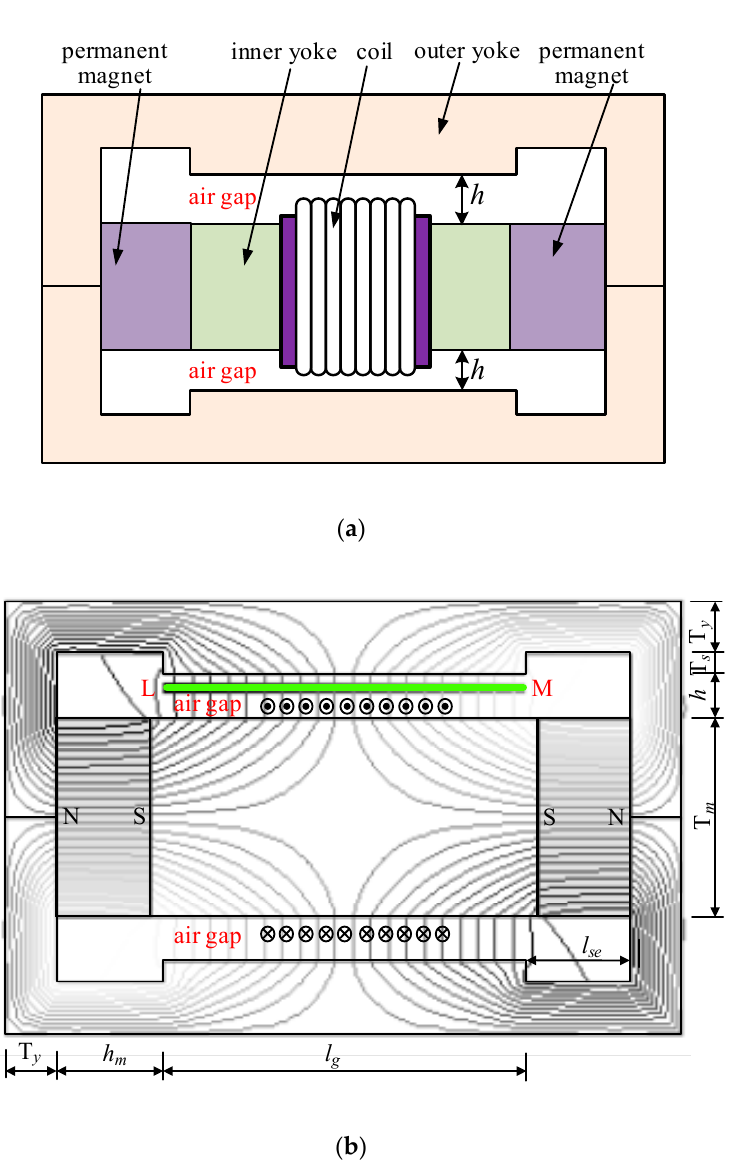
Figure 7. Principle of the proposed electromagnetic actuator: ( a ) scheme of electromagnetic actuator; and ( b ) the simplified two-dimensional structure.